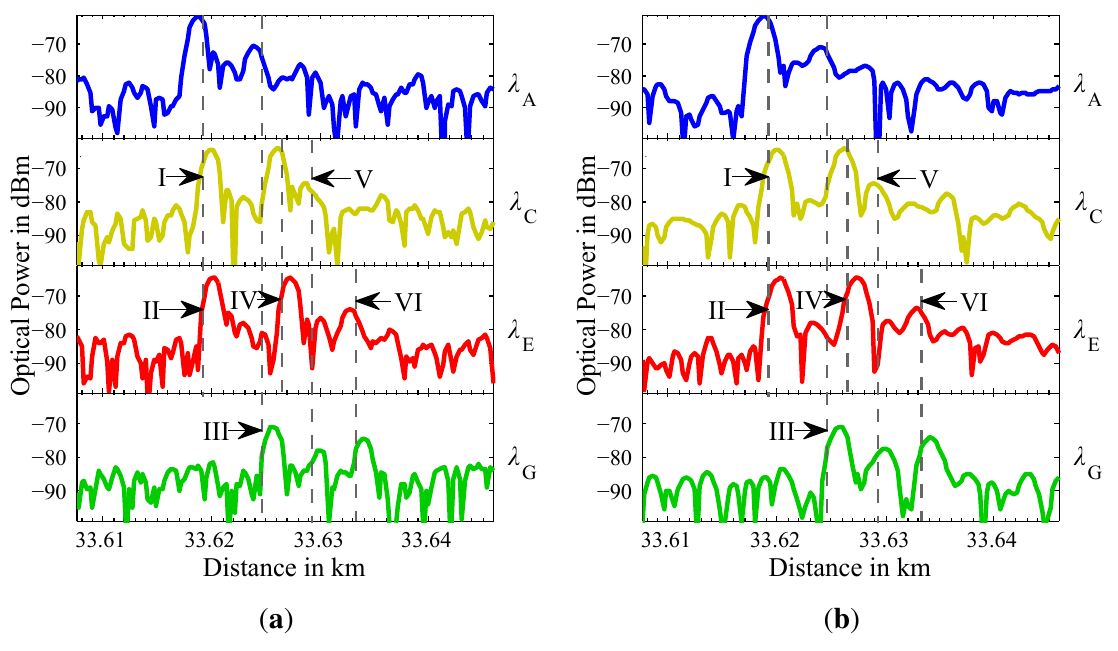
OTDR measurement results using ( a ) L ( b ) L = 512 bit Golay G